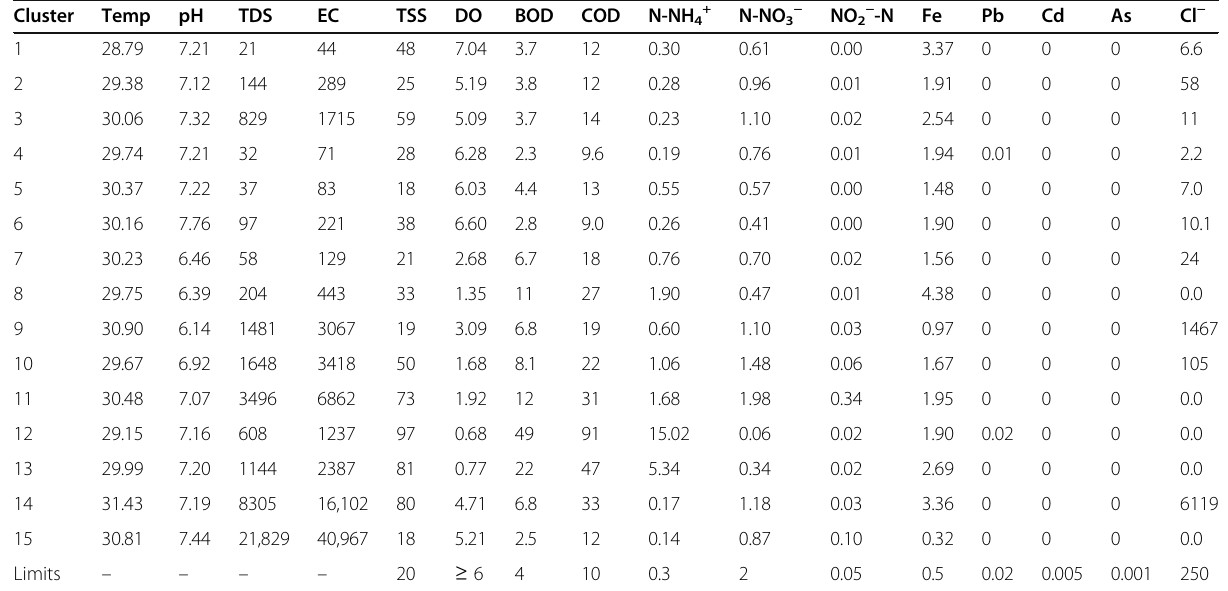
Table 3 Water quality in the identified clusters